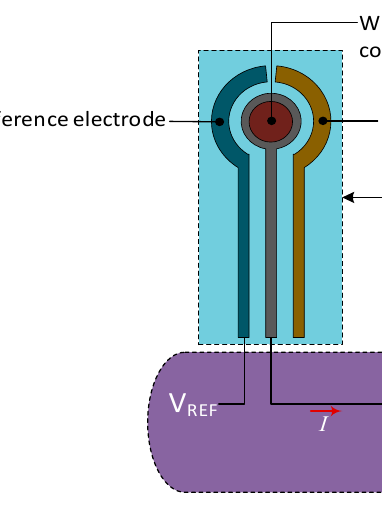
Figure 4. Block diagram of the device for glucose measurement with finger-pricking method.